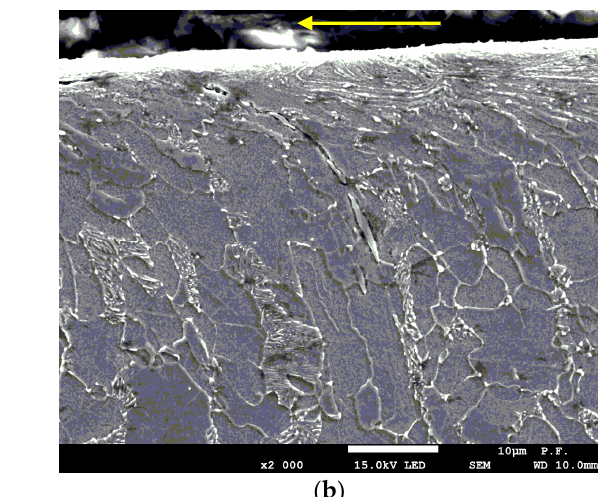
Figure 12. Metallographic microstructure of cross-sectional area of cut (a pressure of 340 MPa and a cutting speed of 300 mm/min). It can be seen that the material cut with an abrasive water jet soon undergoes surface corrosion. This suggests that a large amount of energy is transferred during cutting and stored in the material causing numerous dislocations in the jet impact zone.